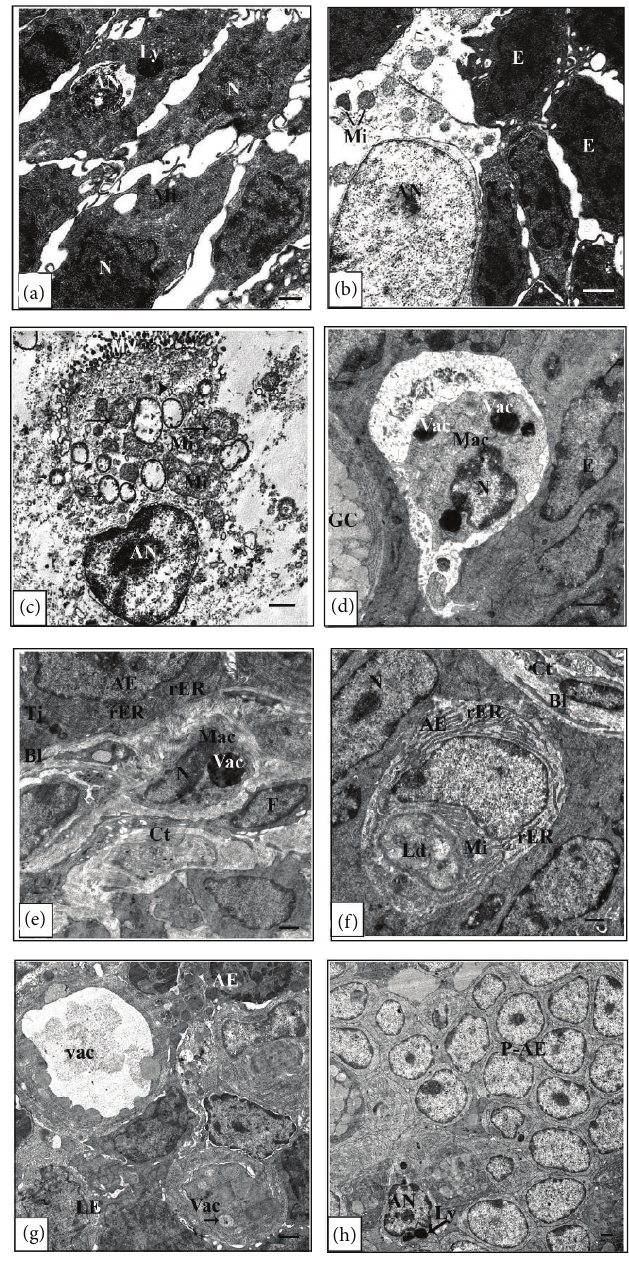
Figure 4: Electron micrographs of the anterior portion of the small intestine of the metamorphic stage 63 ((a)–(h)) showing the following (a): apoptotic nucleus (AN) and lysosomes. (b): degenerating cell with AN. Although the plasma membrane is disrupted, the mitochondria (Mi) retain normal morphological structure. (c): degenerating epithelial cell with AN characterized by chromatin condensation and irregular nuclear envelop. The rough endoplasmic reticulum (rER) was evidently degenerated (arrow heads) and the Mi were swollen (arrows). (d): an intraepithelial macrophage (Mac) with numerous large vacuoles (Vac) and pseudopodium-like processes. (e): phagocytic Mac possessing large Vac in the connective tissue (Ct). F: adult epithelial-connective tissue interface. Epithelial cell contains Mi and numerous rER. The basal lamina (BL) is thick. (g): coexistence of larval (LE) and adult epithelia (AE) at stage 63. Vac are localized in the LE. (h): adult epithelial primordia (P-AE) replace the LE, where AN are detected at stage 63. Scale bar = 1 𝜇